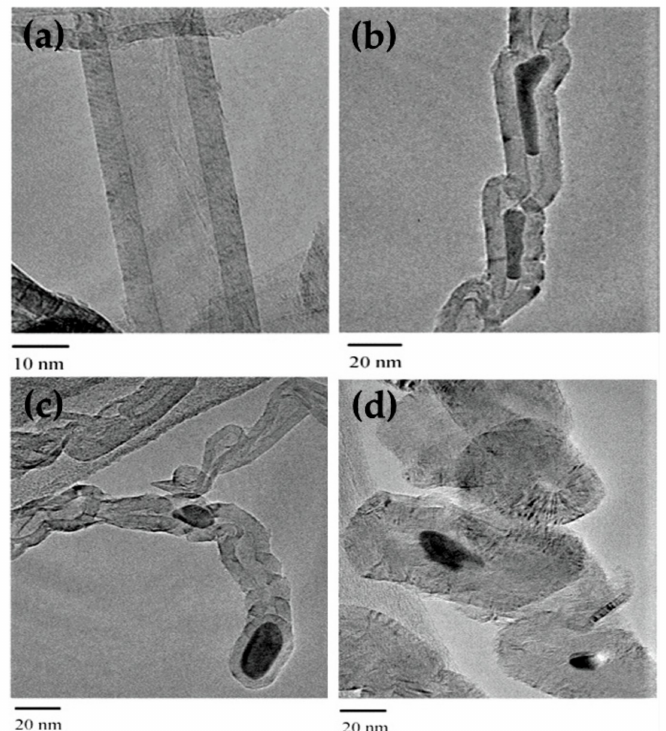
Figure 9. TEM images of different types of carbon formed on spent catalysts: multiwalled carbon nanotubes ( a ), chain-like carbon with cells filled by iron species ( b ), chain-like carbon similar to that of the Fe 2 O 3 /Al 2 O 3 catalyst ( c ), and spherical carbon units without a hollow structure and iron species were sometimes found in the units ( d ); reprinted with permission from ref. [94]. Copyright 2004